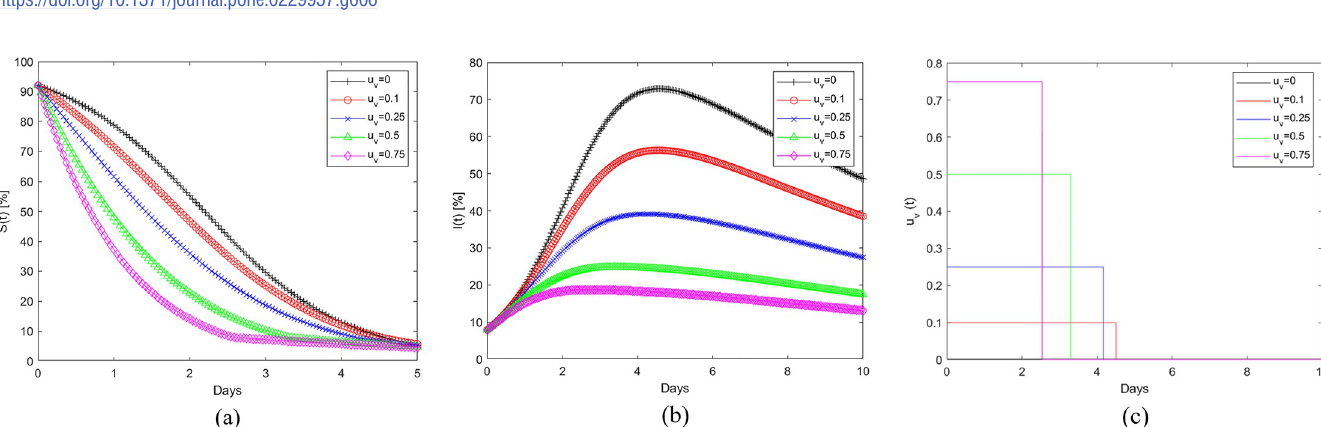
Fig 7. (a) Evolution of susceptible (operational) gas stations and the effect of refueling for Wilmington during Hurricane Florence. (b) Corresponding evolution of Infected or empty fuel stations. (c) The optimal application and switching time, t s , for different refueling rates. https://doi.org/10.1371/journal.pone.0229957.g007 Table 3. Switching times ( t ) corresponding to different per-capita refueling rates ( u s Hurricane City/Area Switching time (t s ) [Days] for Irma Miami-Ft Lauderdale